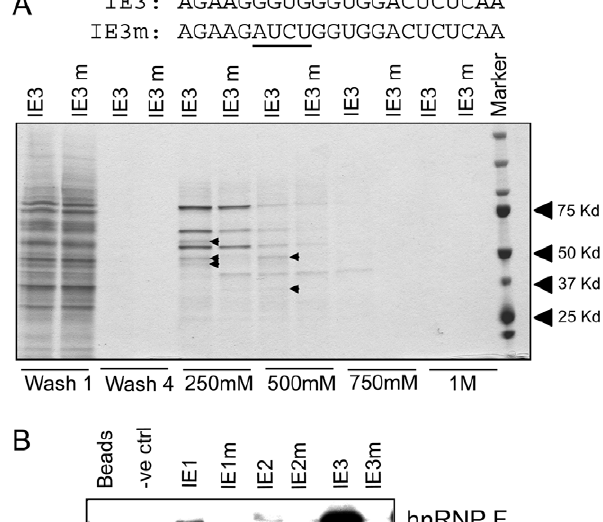
Table 1. Splicing factors bound to IE3 and its mutant by Mudpit